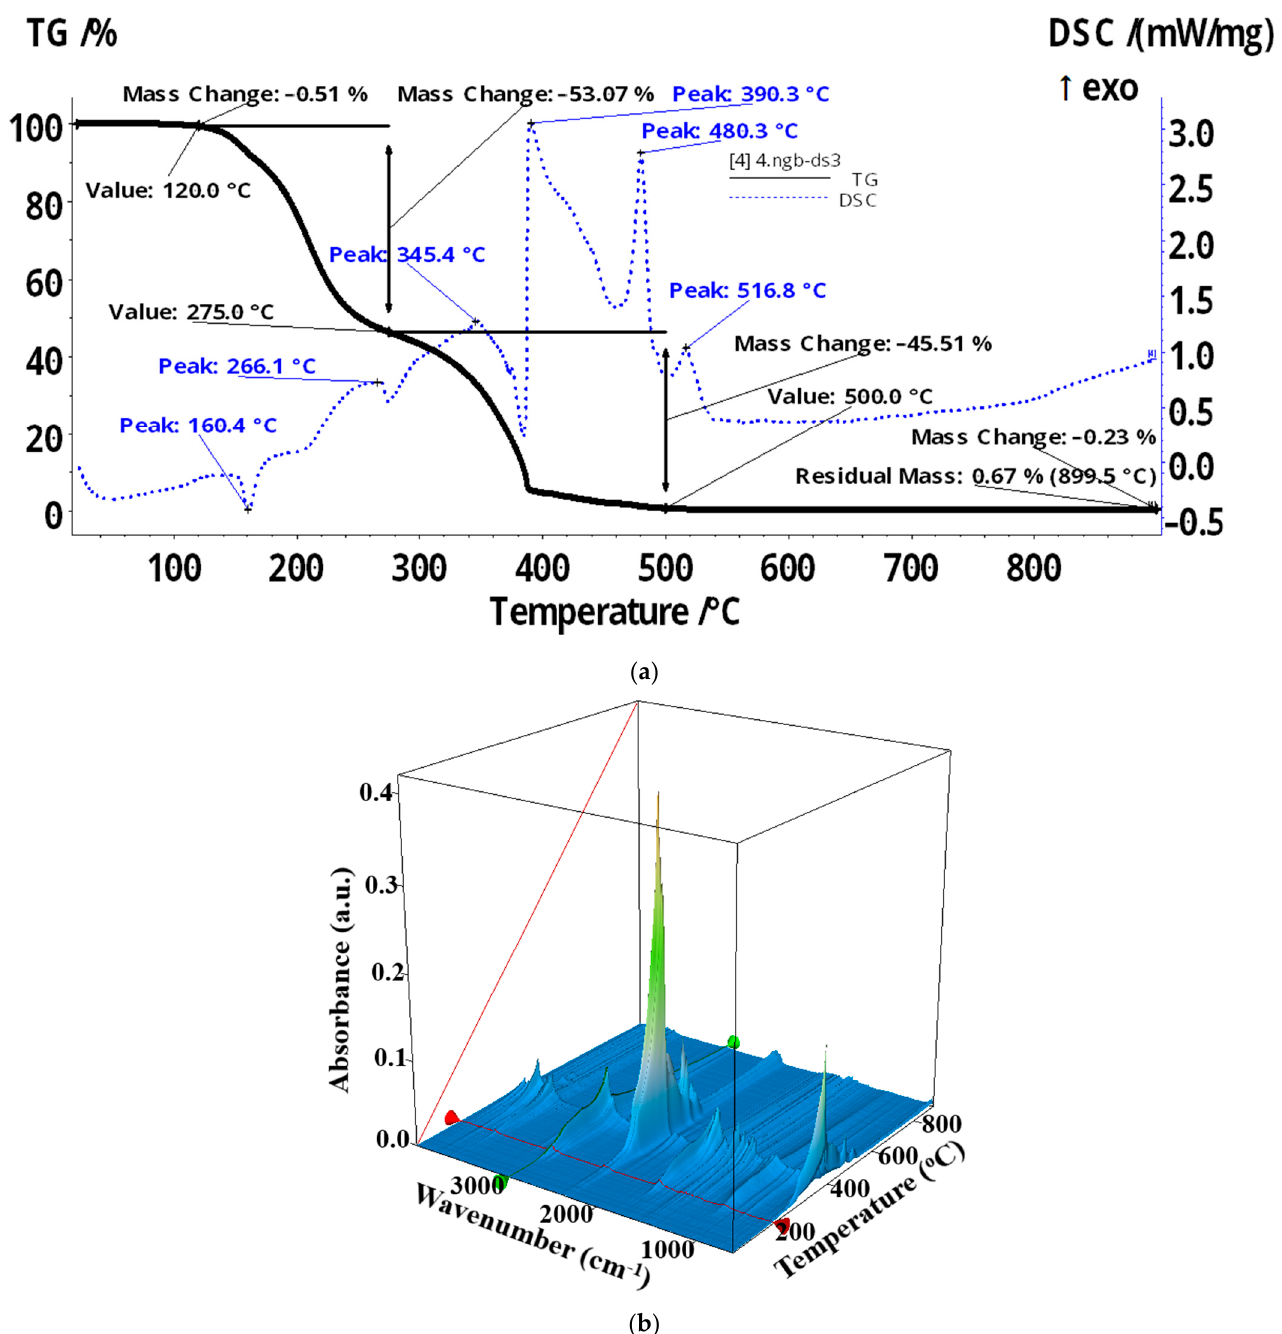
Figure 9. Thermal characteristics ( a ) and the 3D plot of FTIR spectrum vs. temperature ( b ) for the evolved gases from the Os–PPM n sample.